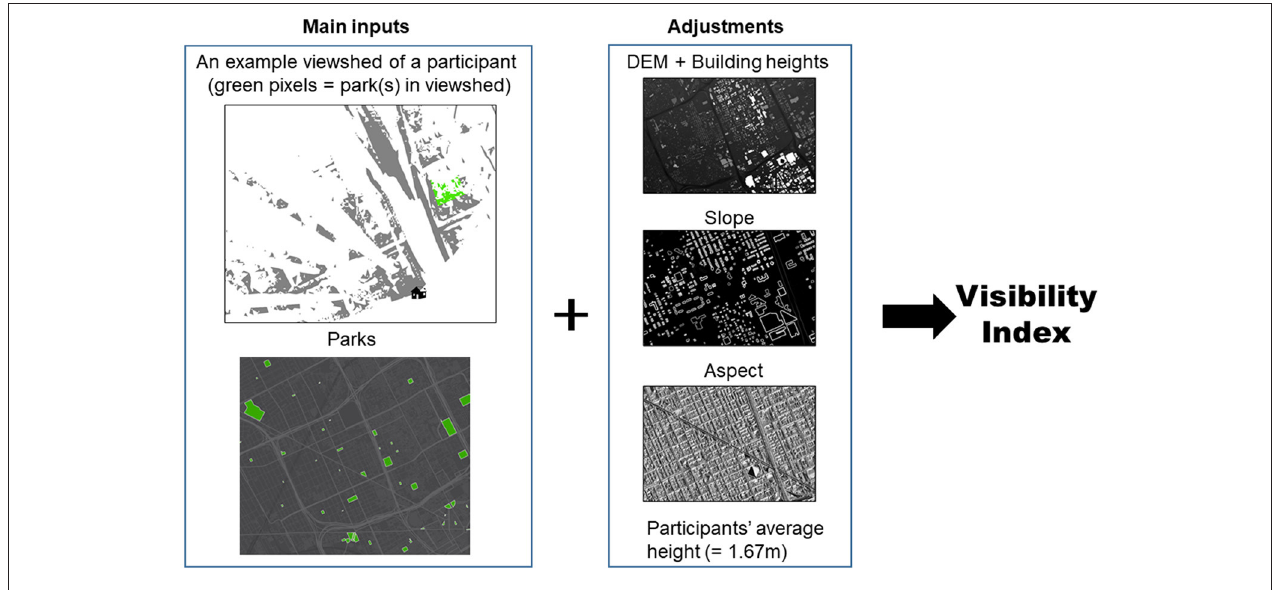
FIGURE 1 | Viewshed analysis process for capturing visibility of greenspace for a participant. viewsheds from a human perspective (Nutsford et al., 2015), we calculated a Vertical Visibility Index (VVI) from each observer location, whereby we accounted for vertical dimensions of visibility (slope, aspect and elevation). The VVI of parks is calculated as the sum of the weighted pixel values of each visible park cell in the viewshed by adjusting for the vertical degrees of visibility between the eye-level of a human and the top and bottom point of each visible park cell. These values were then grouped into tertiles, to represent each 33% higher values in visibility of greenspace in our sample (1 = none or low visibility; 3 = high